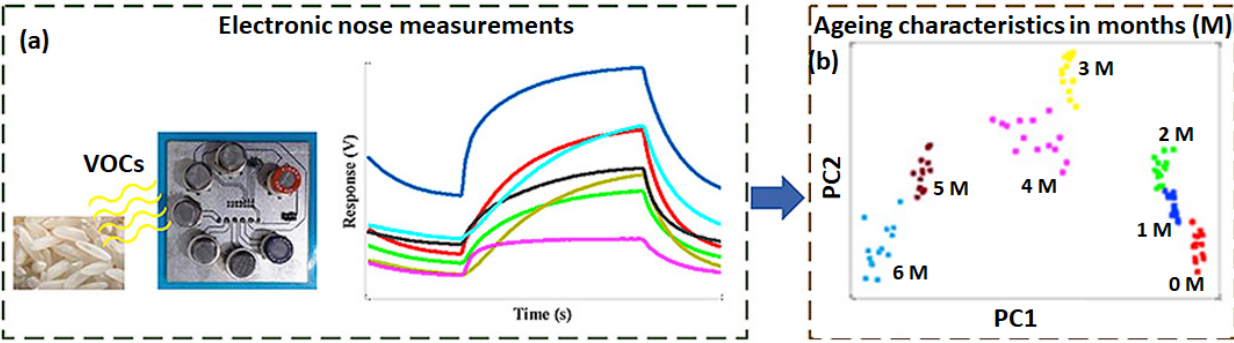
Figure 8. Schematic of rice aroma sensing by MOS gas sensors array and the observed response curves of the sensors in the array ( a ). A PCA score plot of the different aromatic samples collected for a storage period between 0 months and 6 months is shown ( b ). Month is represented as M in the graph. Adapted from ref. [100].